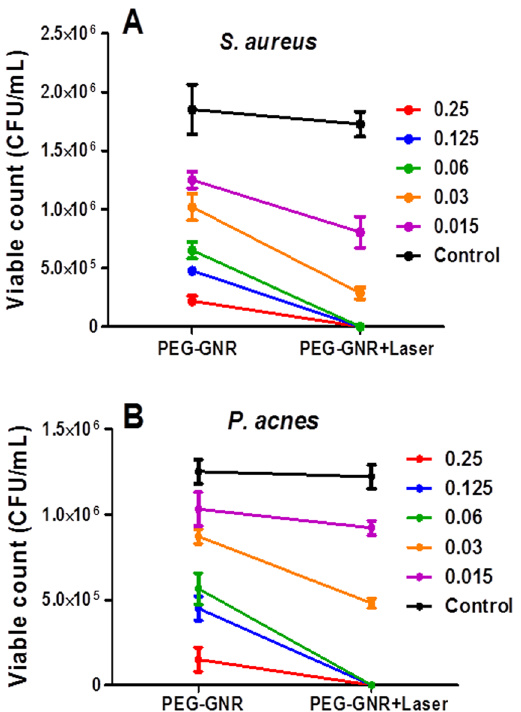
Figure 4. Effect of NIR laser exposure of bacteria pre-treated with PEG-GNR. ( A) Bacterial viable count of S . aureus treated with different concentrations (nM) of PEG-GNR compared to those treated with PEG-GNR followed by exposure to laser beam. ( B ) Bacterial viable count of P . acnes treated with different concentrations (nM) of PEG-GNR compared to those treated with PEG-GNR followed by exposure to laser beam. Control: bacteria exposed to laser beam alone without